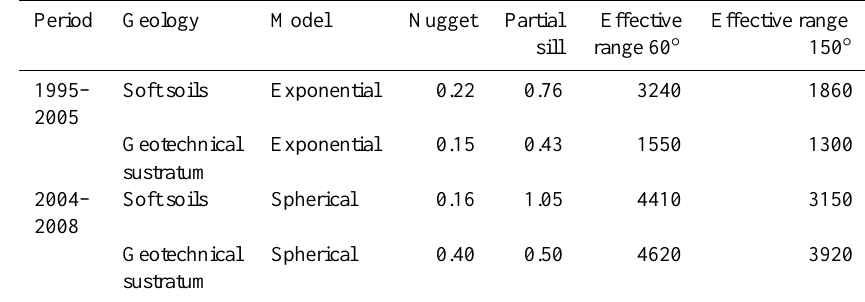
Table 4. Parameters of the variogram models for each normalized PS data group.